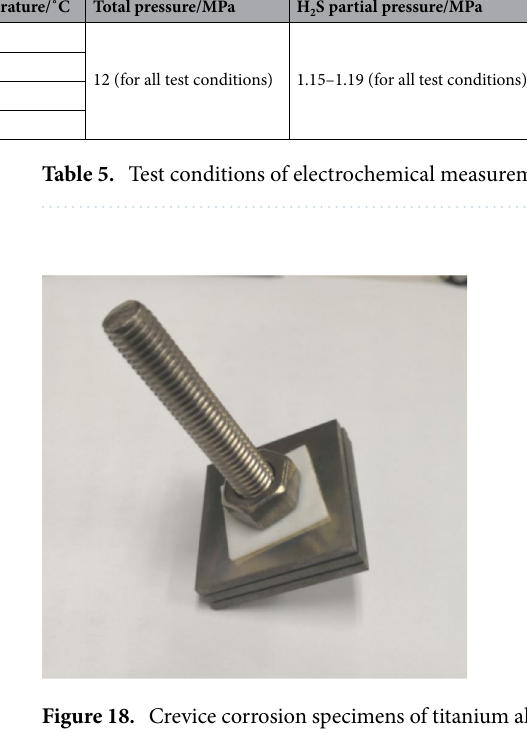
Figure 18. Crevice corrosion specimens of titanium alloys used in